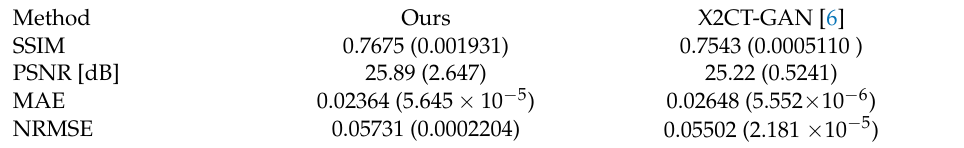
Table 3. Means of metrics ( N = 2, standard-dose protocol). We show variances in brackets. Method